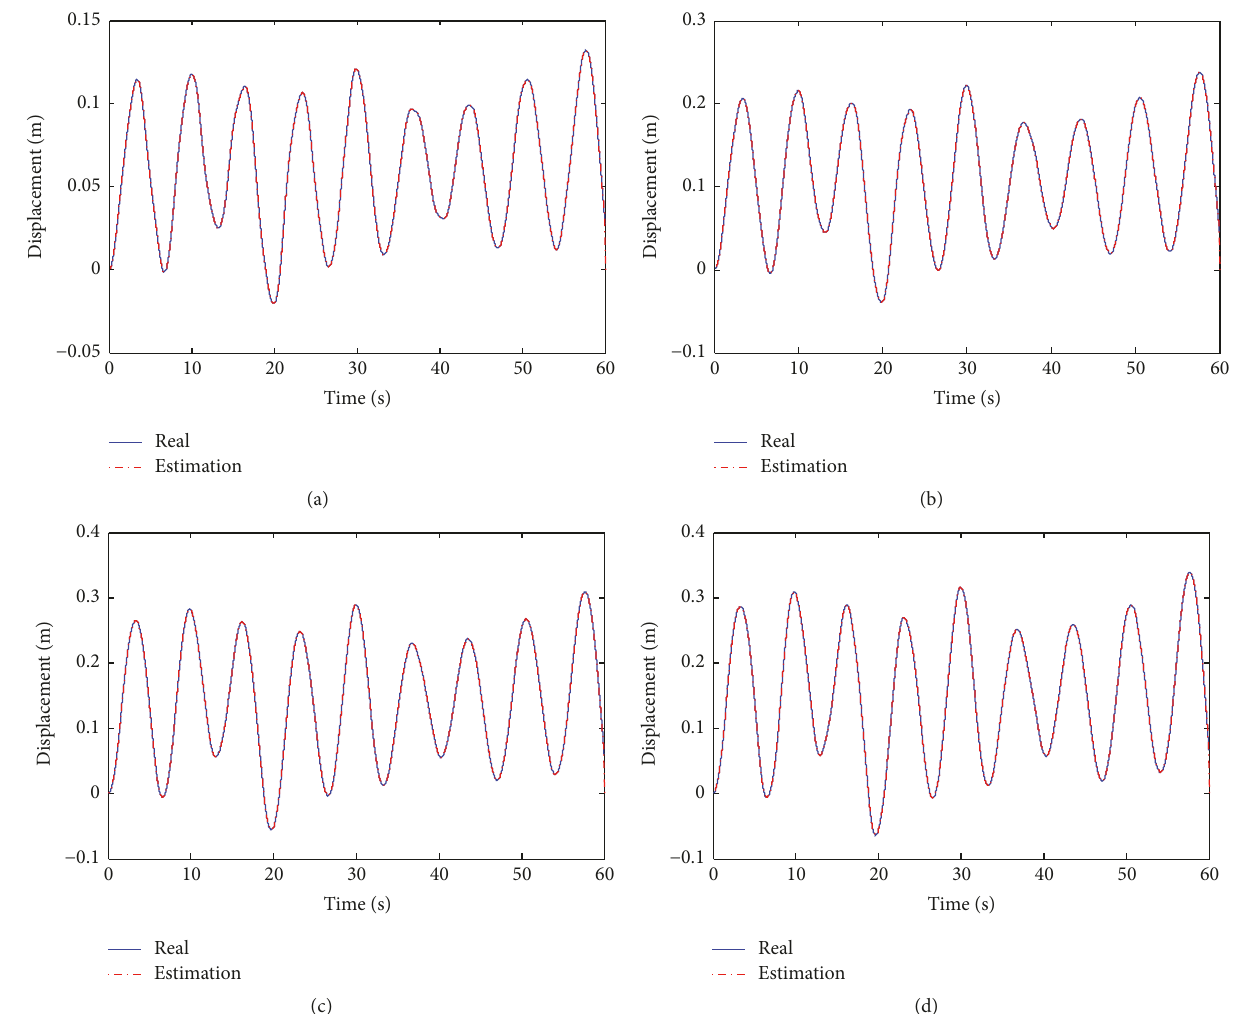
Figure 3: Comparison of time histories of structural displacement responses. (a) On the 5th floor; (b) on the 10th floor; (c) on the 15th floor; (d) on the 20th